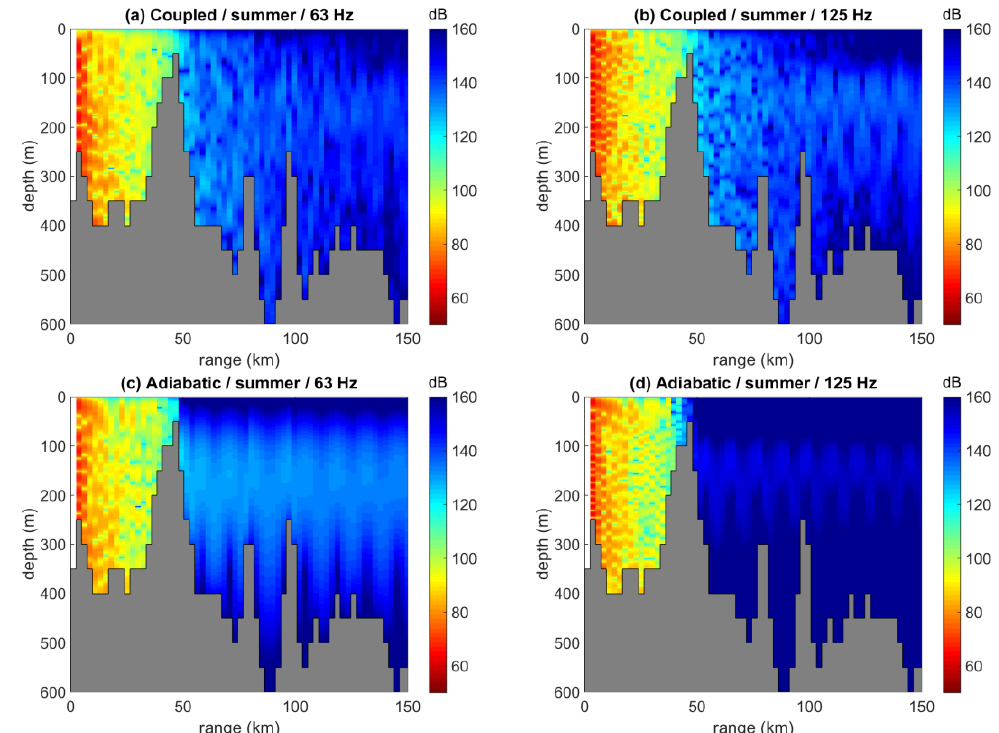
Figure 7. Transmission loss (dB) along transect AB for the summer SVP for a source depth of 5 m. ( a ) Coupled-mode results at 63 Hz; ( b ) Coupled-mode results at 125 Hz; ( c ) Adiabatic results at 63 Hz; ( d ) Adiabatic results at 125 Hz.